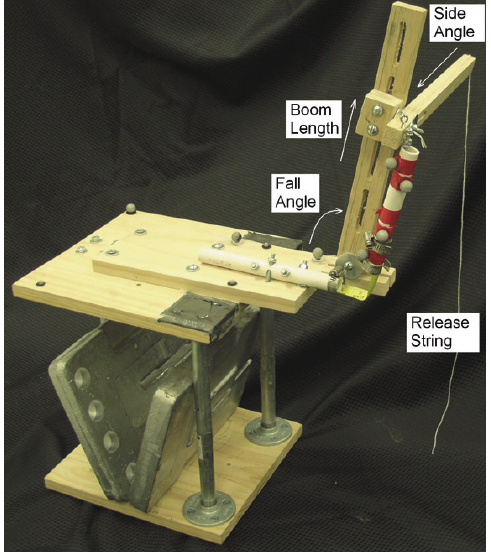
Fig. 3. The test stand allows for repeatable tests with a consistent start position and